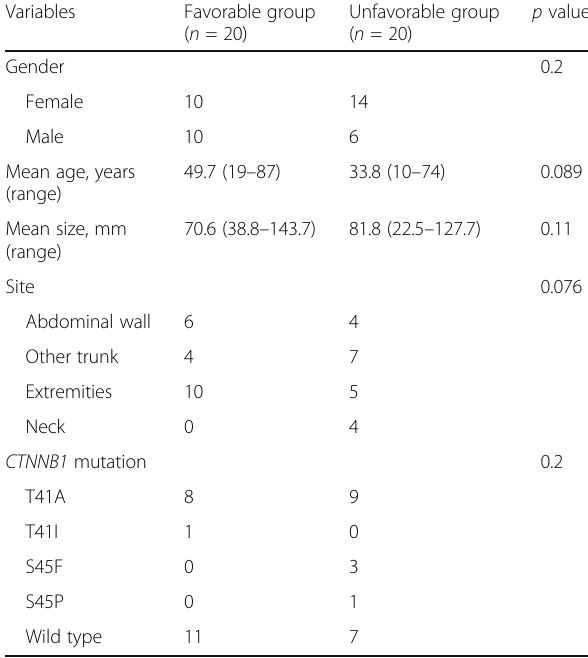
Table 1 Patients characteristics between two prognosis group